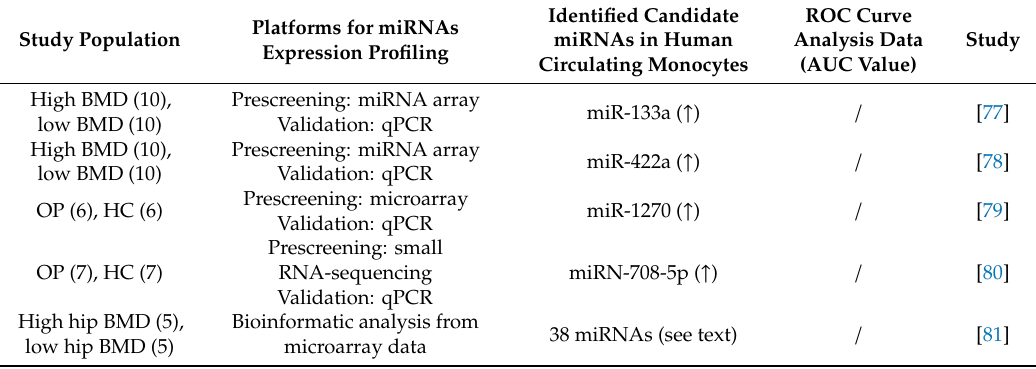
Table 2. Overview of di ff erentially expressed miRNAs in circulating monocytes isolated from osteoporotic (OP)